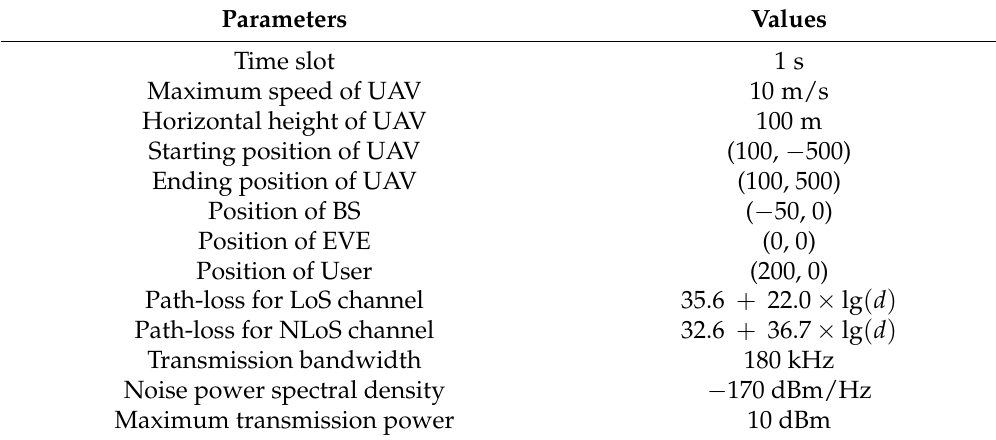
Table 1. Simulation